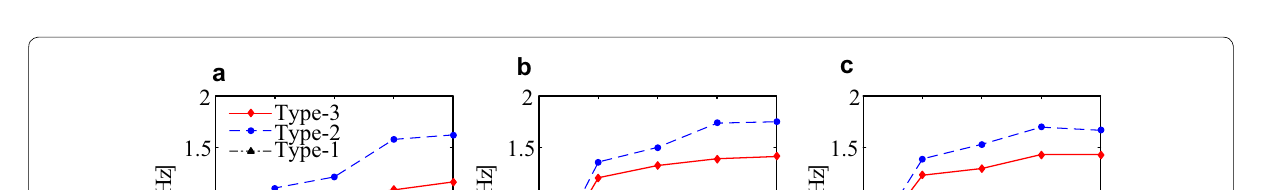
Fig. 5 The particle trajectories of a Type-1, b Type-2, c Type-3 and d Type-0